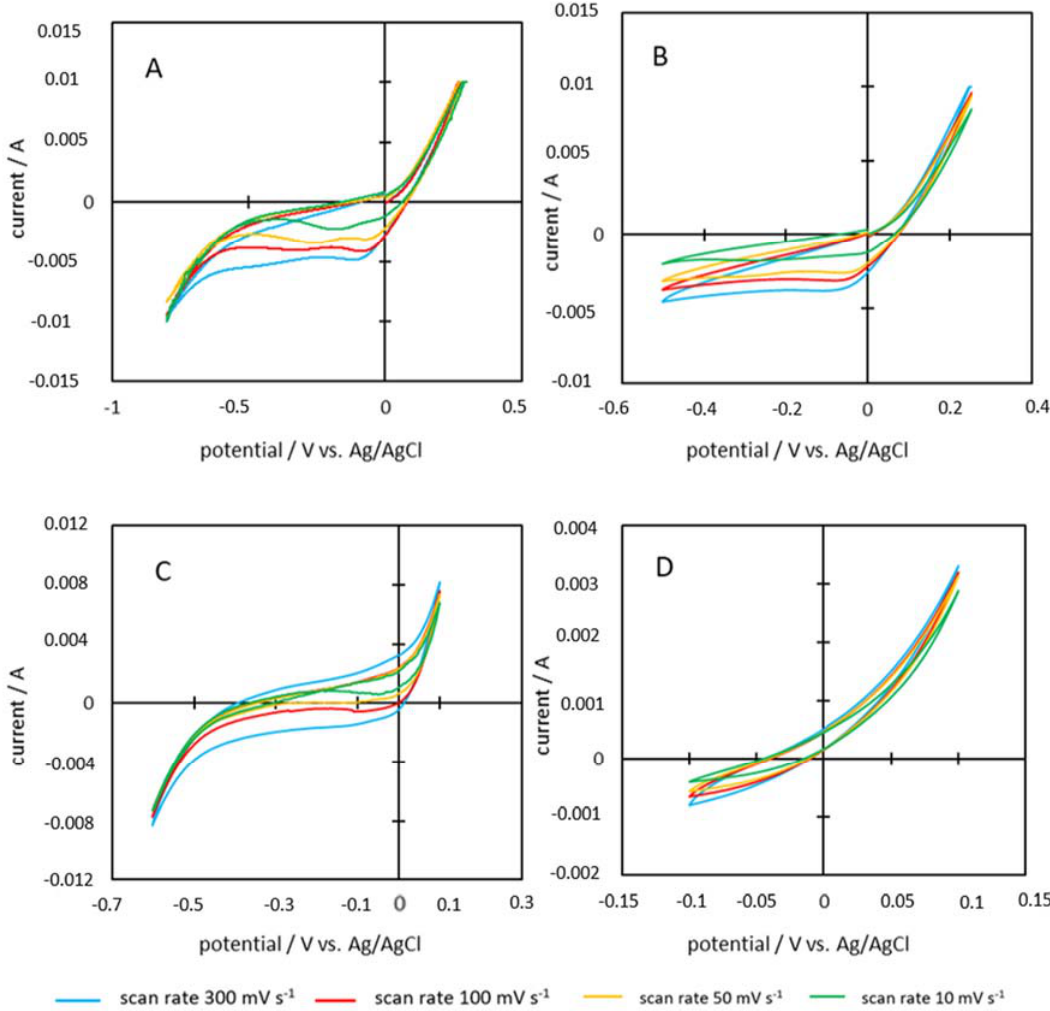
Figure 12. Cyclovoltamograms of the samples ( A ) P600 ‐ 200 ‐ 2, ( B ) P600 ‐ 200 ‐ 5, ( C ) P600 ‐ 220 ‐ 2, and ( D ) P600 ‐ 220 ‐ 5.